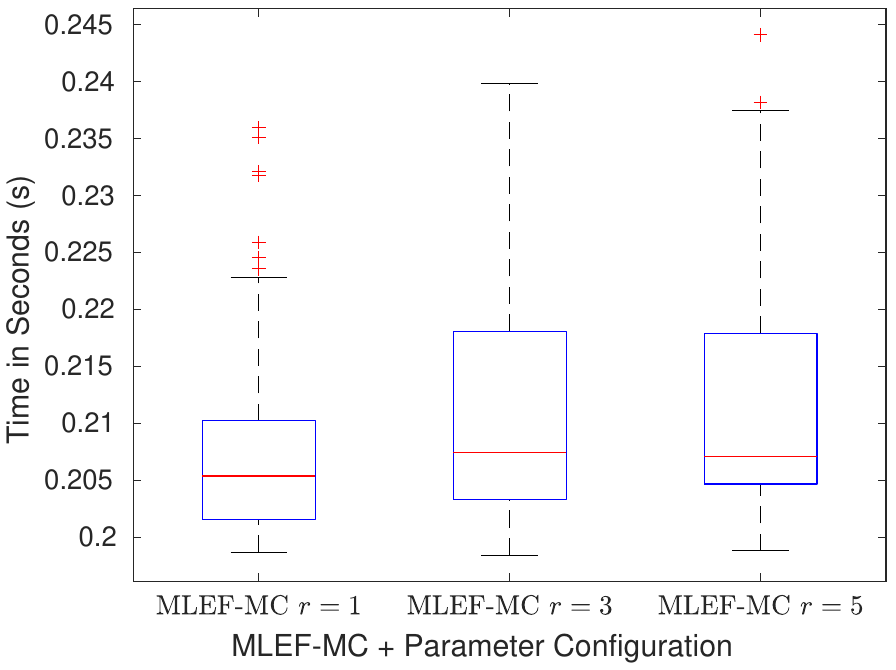
Figure 9. Average of elapsed times (in seconds) of the assimilation step for the MLEF-MC. Different parameters r were tried during experiments.